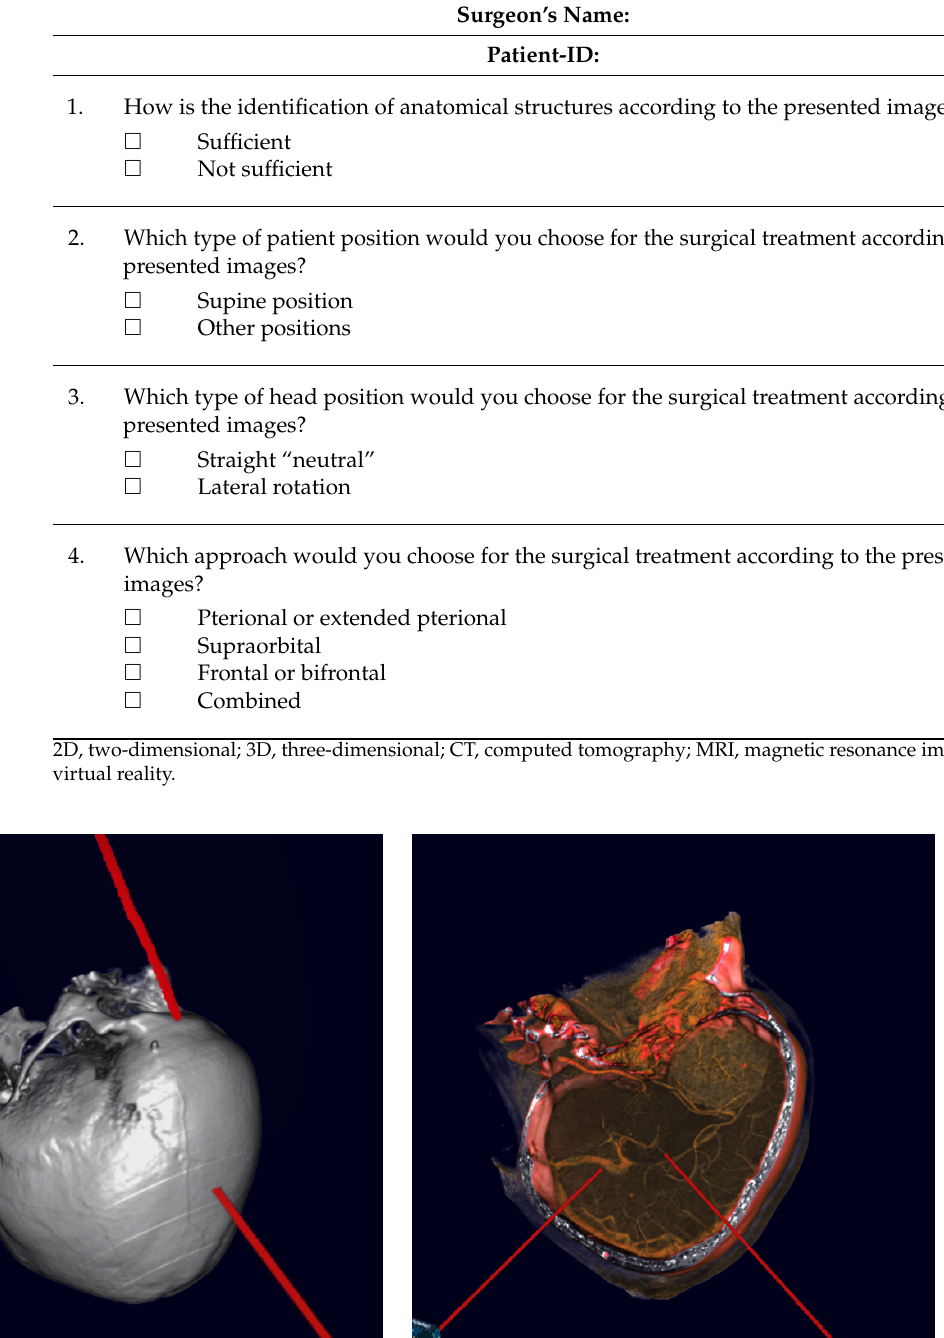
Table 1. Questionnaire regarding the anatomical structure detection as well as the recommended surgical strategy for patients with anterior skull base meningiomas, using conventional CT and MRI modalities (2D and screen 3D) or 3D-VR presentations.